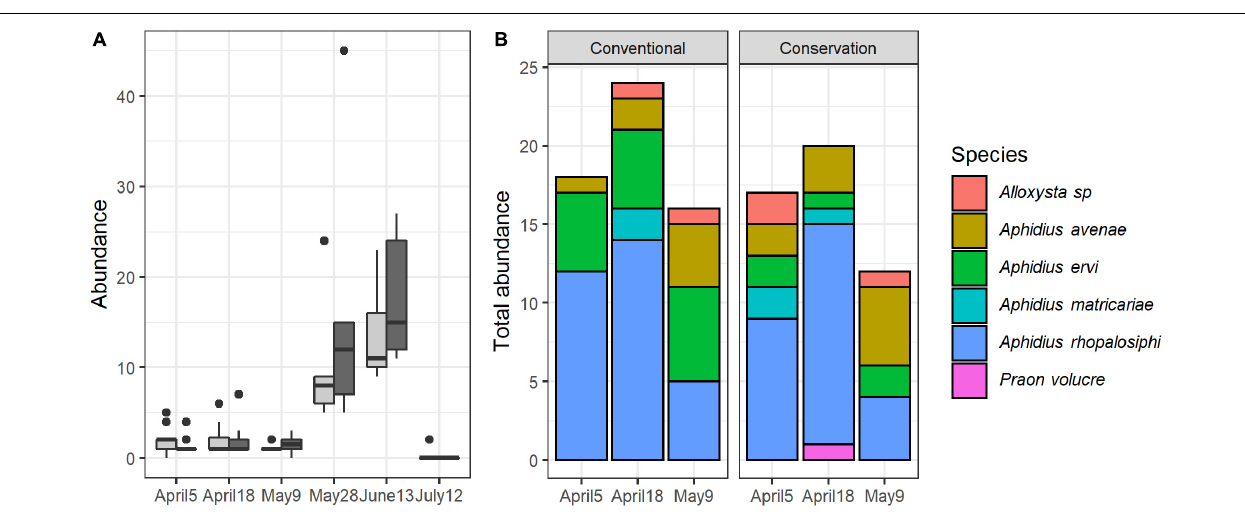
FIGURE 6 | Variations of parasitoid abundance per field over time and according to soil management (A) and of the cumulative abundance of parasitoid species for the first three sampling sessions (B)